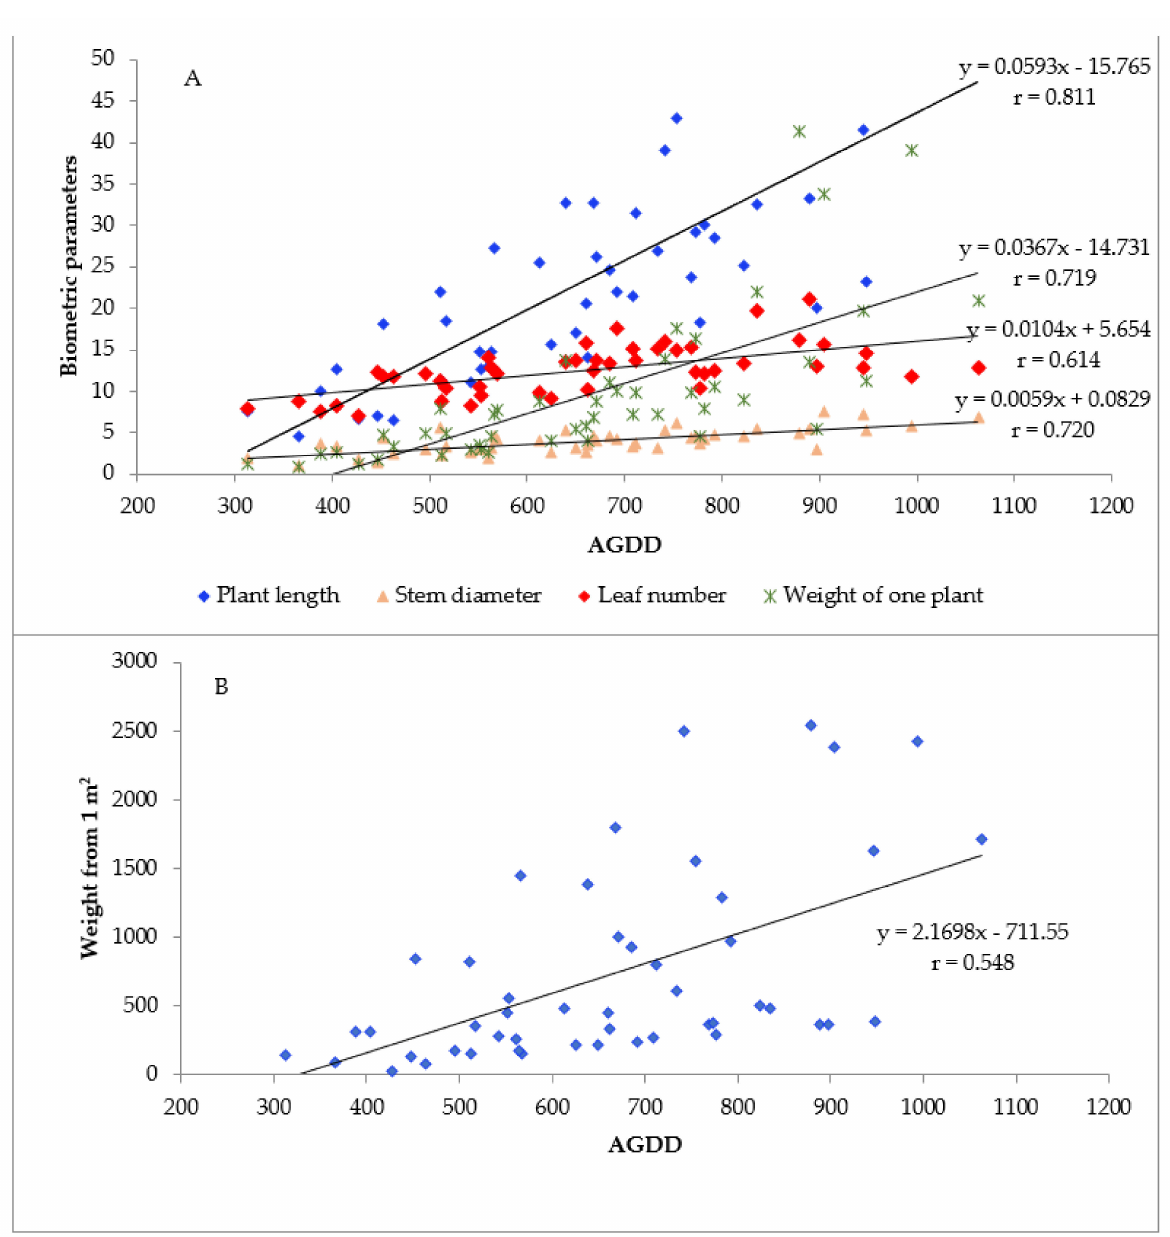
Figure 3. Effect of thermal condition presented in accumulated growing degree days of the quinoa biometric parameters ( A ) and fresh biomass yield ( B